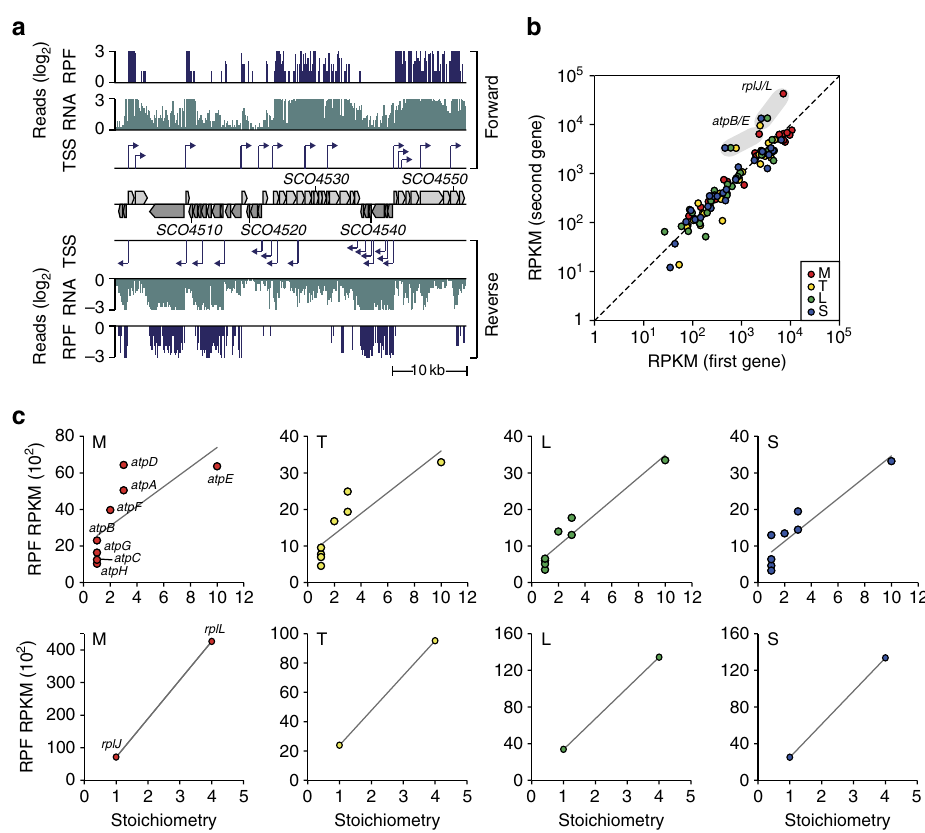
Figure 4 | Determination of the translatome of S. coelicolor . ( a ) An example of visualization of transcription start sites (TSS), mRNA expression profiles (RNA) and ribosome-protected fragment profiles (RPF) at genomic region between 4,924,959 and 4,969,730. ( b ) RPF read data for the first and the second gene in the operon were compared at four growth phases: M, mid-exponential phase; T, transition phase; L, late exponential phase; S, stationary phase. ( c ) RPF data for ribosomal proteins RplJ and RplL (stoichiometry ¼ 1:4) and ATP synthase operon encoding AtpB, AtpE, AtpF, AtpH, AtpA,